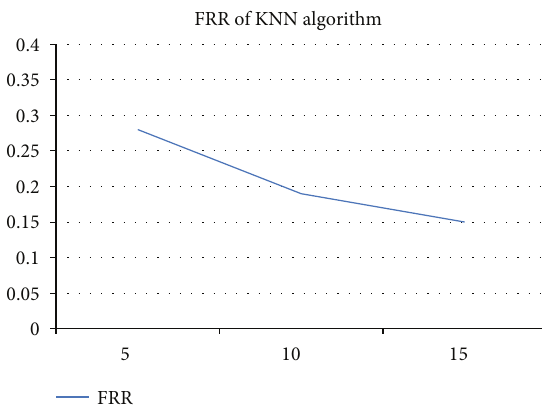
Figure 11: The experimental analysis using KNN